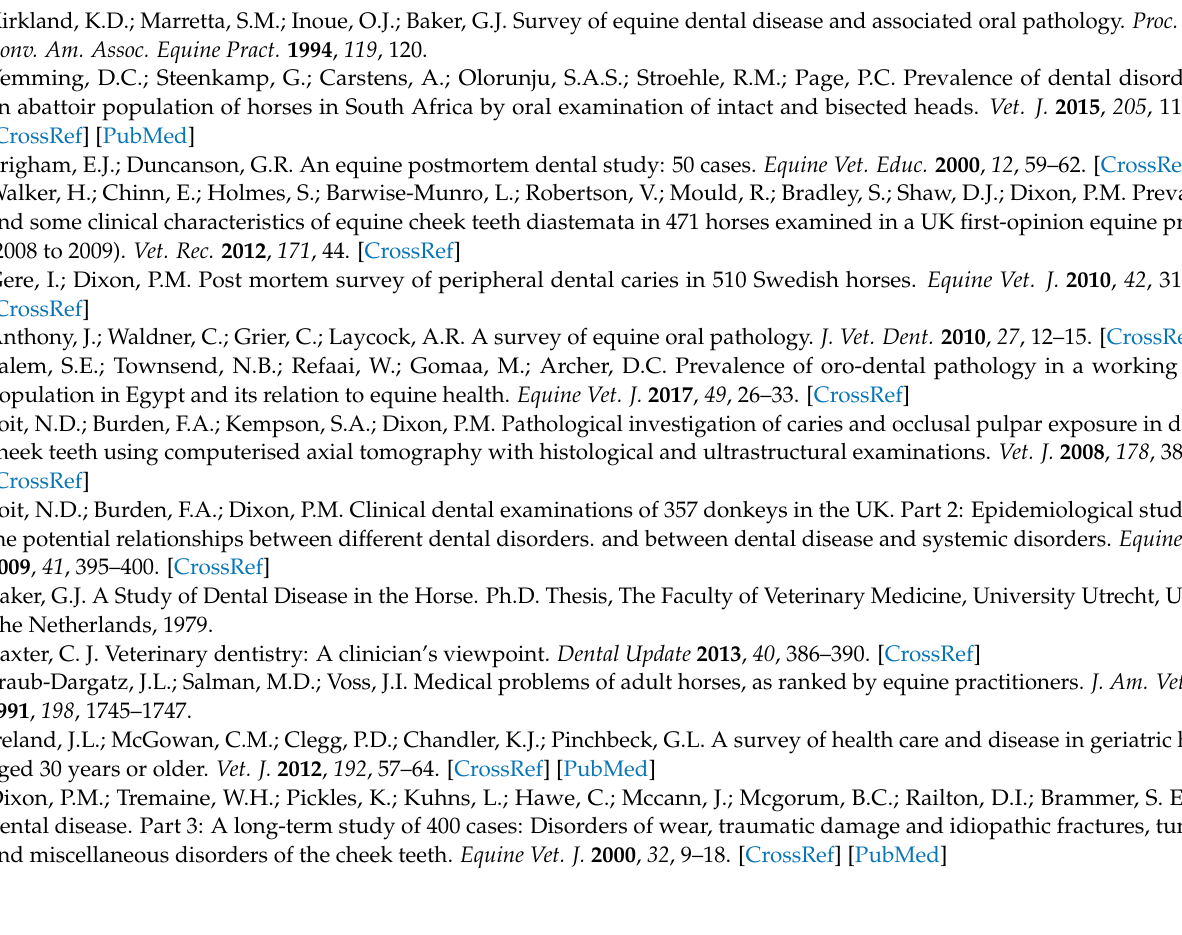
Table S1: The definitions of selected disorder (malocclusions and dental diseases) of the incisor teeth, Table S2: The definitions of selected disorder (malocclusion and dental diseases) of the canine teeth, Table S3: The definitions of selected disorder (malocclusion and dental disease) of the wolf teeth, Table S4: The definitions of selected disorder (malocclusions and dental diseases) of the cheek (premolar and molar)